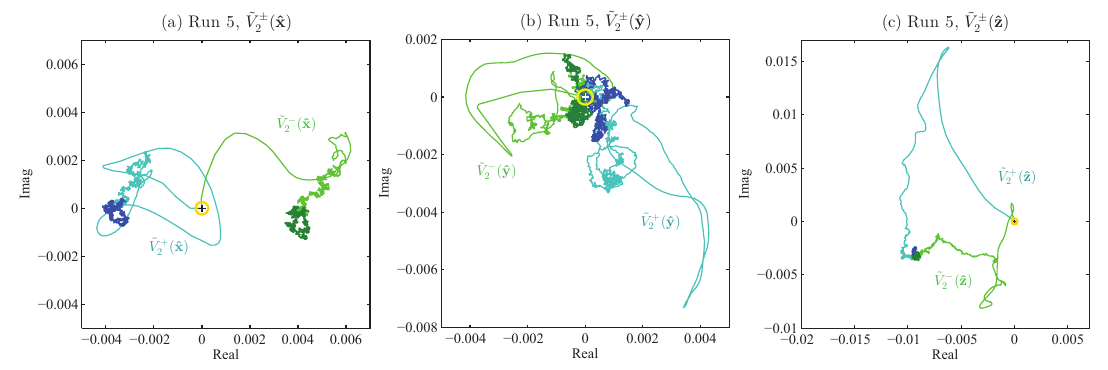
( ˆ k , t ) , ˆ k = ( a ) ˆ x , ( b ) ˆ y and ( c ) ˆ z , from Run 5. (The variables are Figure 8. Phase portraits of ˜ V + 2 ˜ b ˜ V + ( ˆ x , t ) ( ˆ y , t ) [ ˜ b + ( ˆ y , t ) ˜ u + ( ˆ y , t )] and normalized by N 3/2 , N = 128.) Here, ˜ V + + ( ˆ x , t ) , 2 2 ∼ ∼ − ˜ b ˜ V + ( ˆ z , t ) + ( ˆ z , t ) . Light parts are the full trajectories, while dark parts are the last half of the 2 ∼ trajectories, i.e., from 0.5 t end to t end . ( a , c ) indicate stationarity and coherent structure, dynamic results quite different from expected behavior as exemplified by ( b ). Yellow circles indicate the predicted average magnitude.